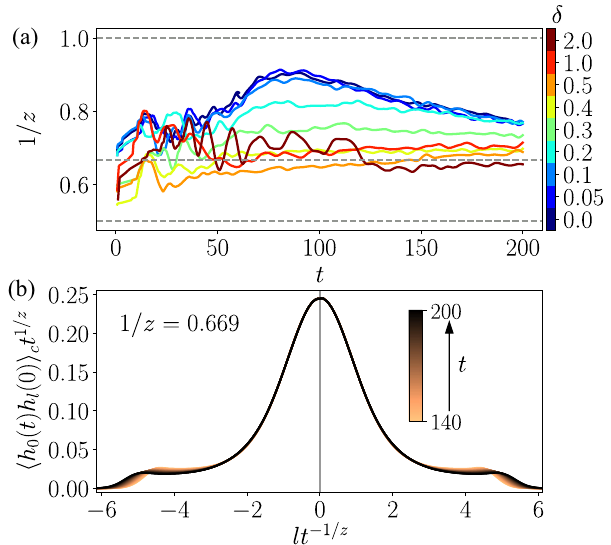
FIG. 5. Stable superdiffusive energy transport for a large PNP deformation of the PXP model. (a) Sufficiently large deformations δ ≥ 0 . 4 lead to a clear superdiffusive exponent z ≈ 1 . 5 . (b) Single- parameter scaling of the spatial profiles of the connected corre- lation function for δ ¼ 0 . 5 shows a collapse for 1 =z ≈ 0 . 669 (average value of 1 =z in the interval t ∈ ½ 100 ; 200 (cid:2) ). The ballis- tically propagating peaks at large j x j are expected to disappear as t → ∞ . The data is for N ¼ 1024 sites with bond dimensions χ ¼ 384 for δ ¼ 2 and χ ¼ 256 for δ ≤ 1 . For clarity purposes, data in panel (a) has been smoothed using a Gaussian